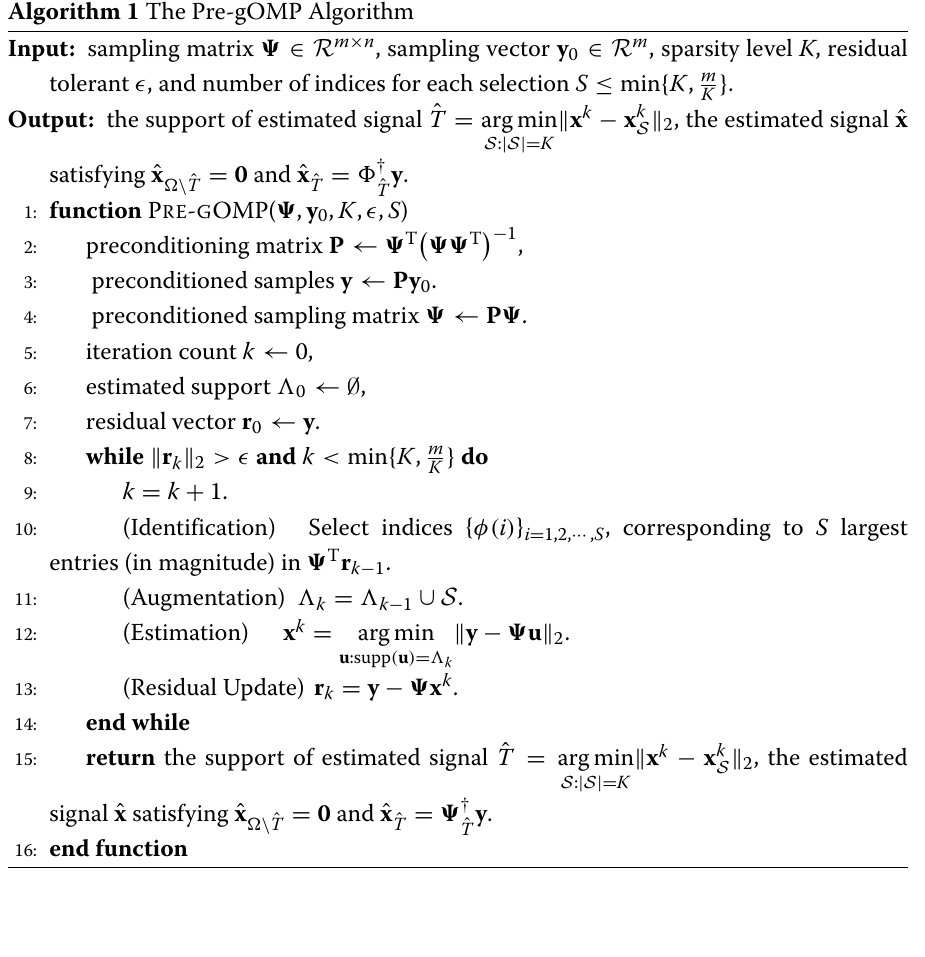
Algorithm 1 The Pre-gOMP